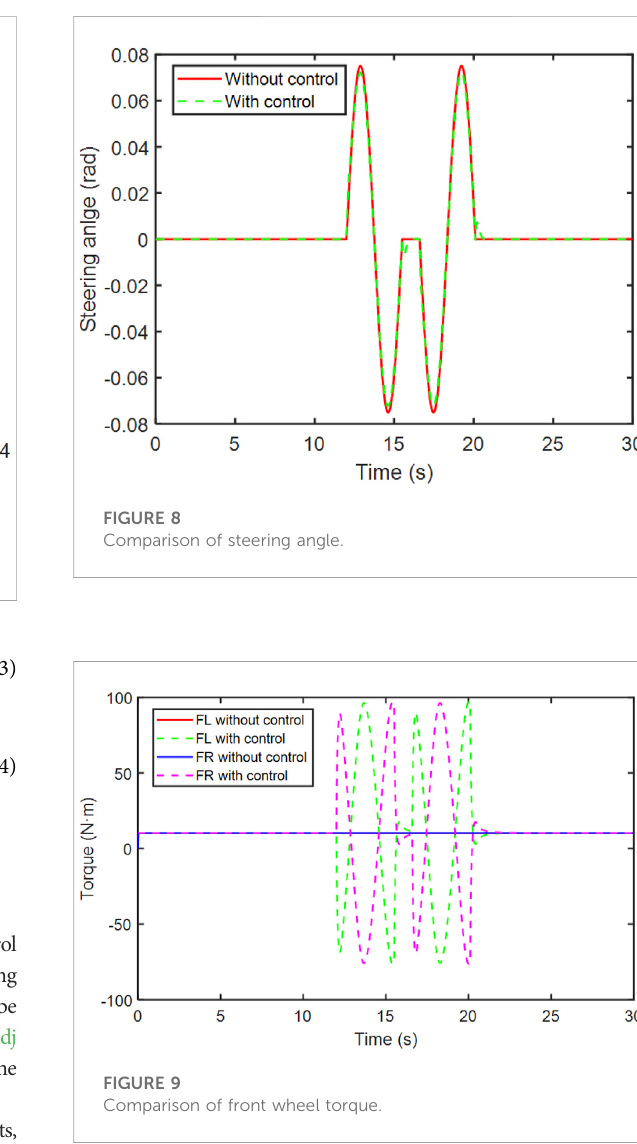
FIGURE 9 Comparison of front wheel